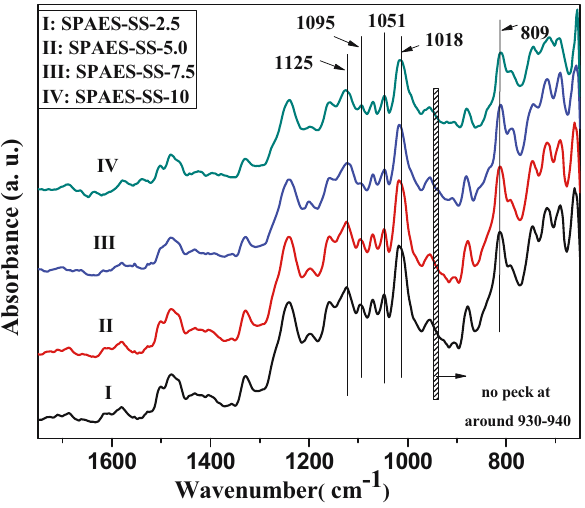
Figure 3: FT - IR spectra of SPAES - SS - X hybrid membranes.